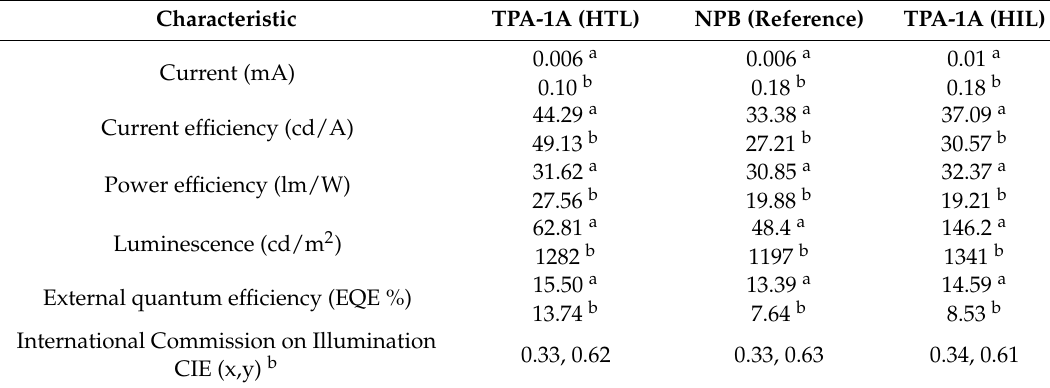
Table 2. Device properties of TPA-1A (HTL) with reference N , N ′-Di(1-naphthyl)- N , N ′-diphenyl-(1,1′- biphenyl)-4,4′-diamine NPB and TPA-1A (HIL).